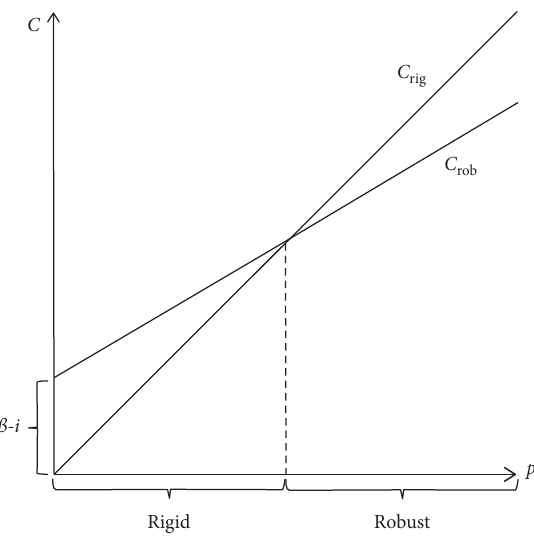
Figure 7: Analogy of the final fees of adamant with robust SC (source: